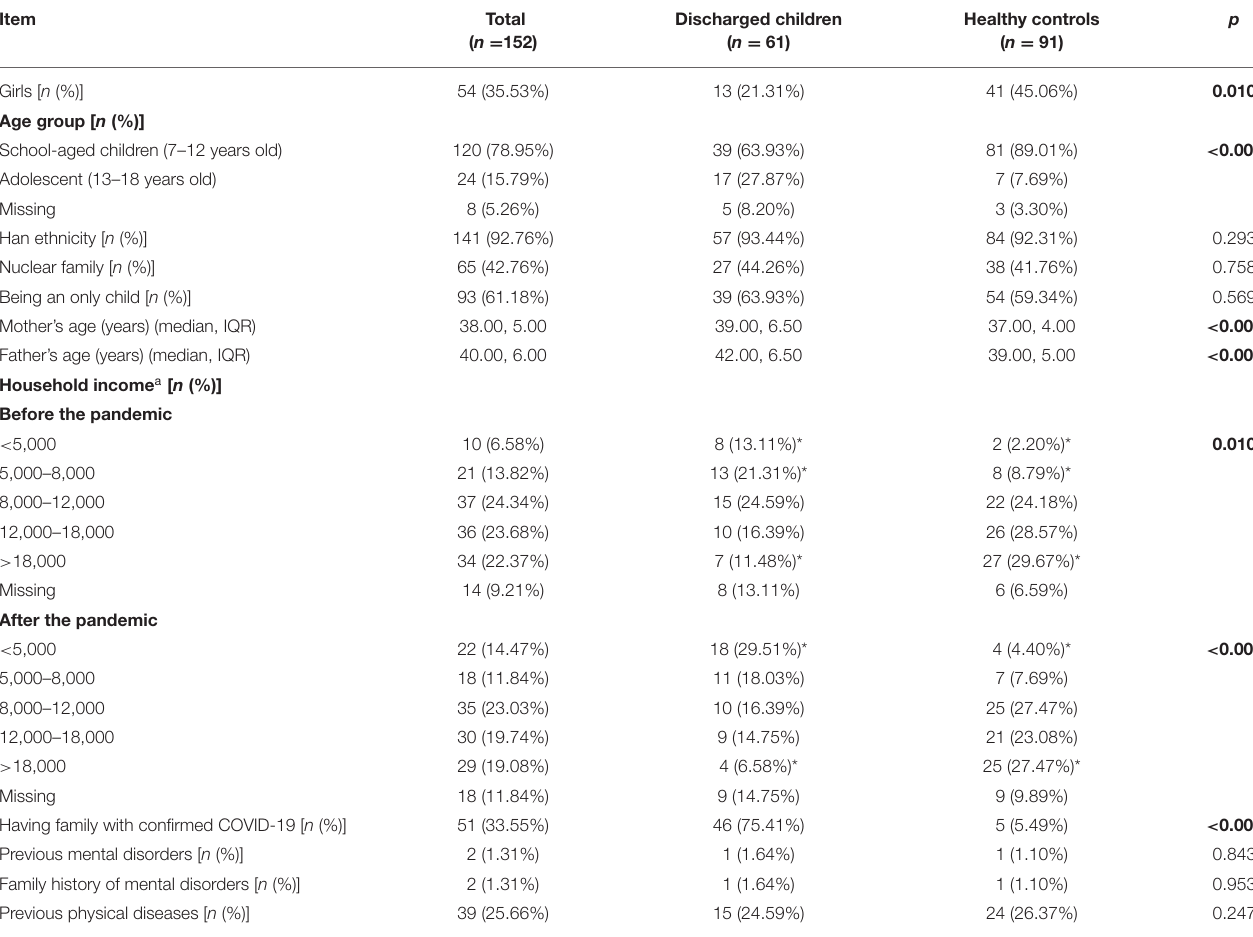
TABLE 1 | Description and comparison of demographic characteristics ( n =